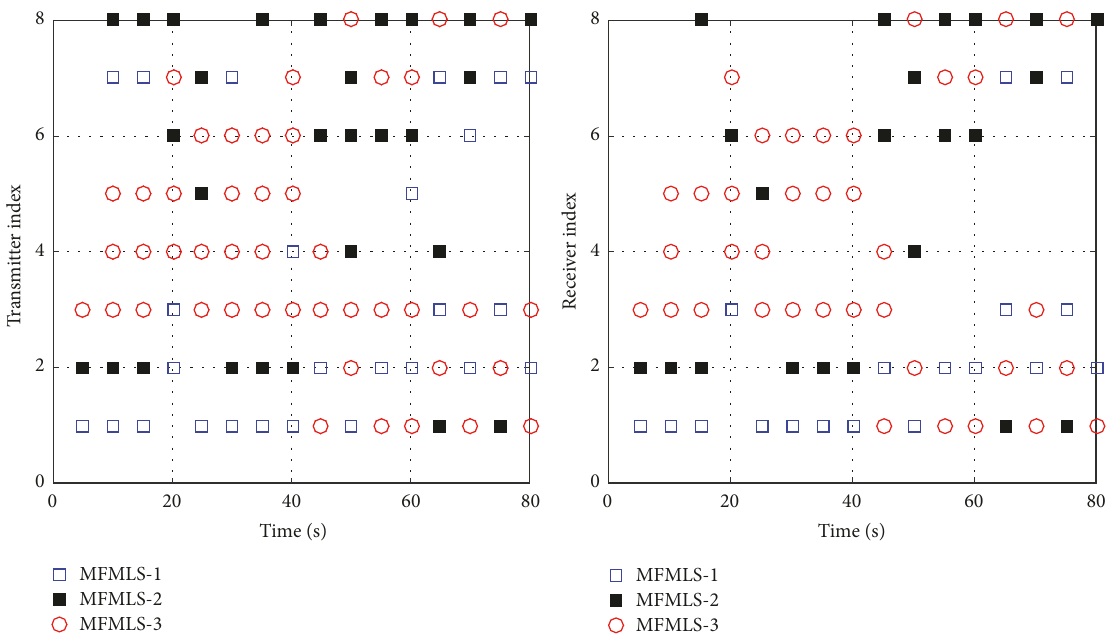
Figure 4: Optimal antenna selection result by MFMLS